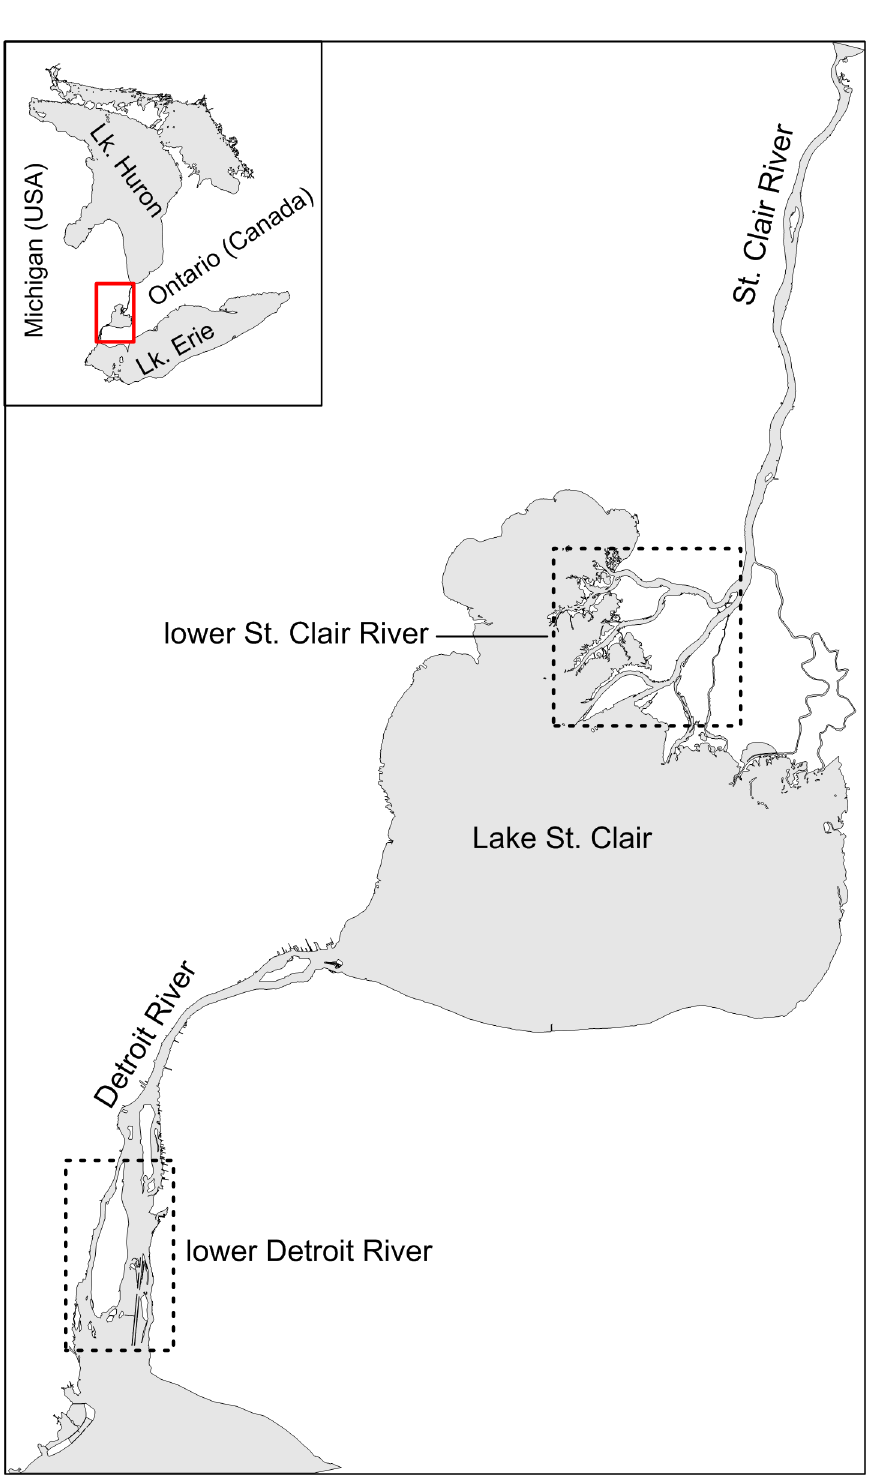
Fig 1. The Detroit-St. Clair River system. Dashed boxes delineate the extent of the lower Detroit and lower St. Clair rivers. The direction of flow is from Lake Huron to Lake Erie (i.e., from north to south).